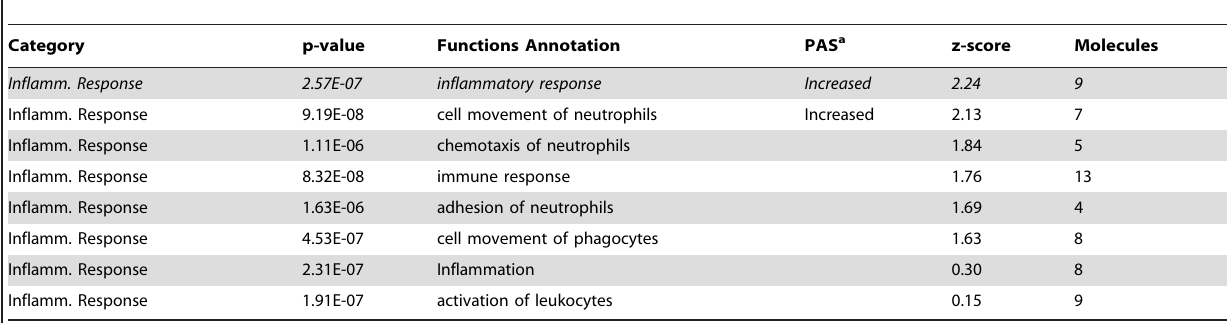
Table 4. Top biological pathways associated with changes in inflammation-associated gene expression in H 3 RKO vs. WT LN after CFA + PTX